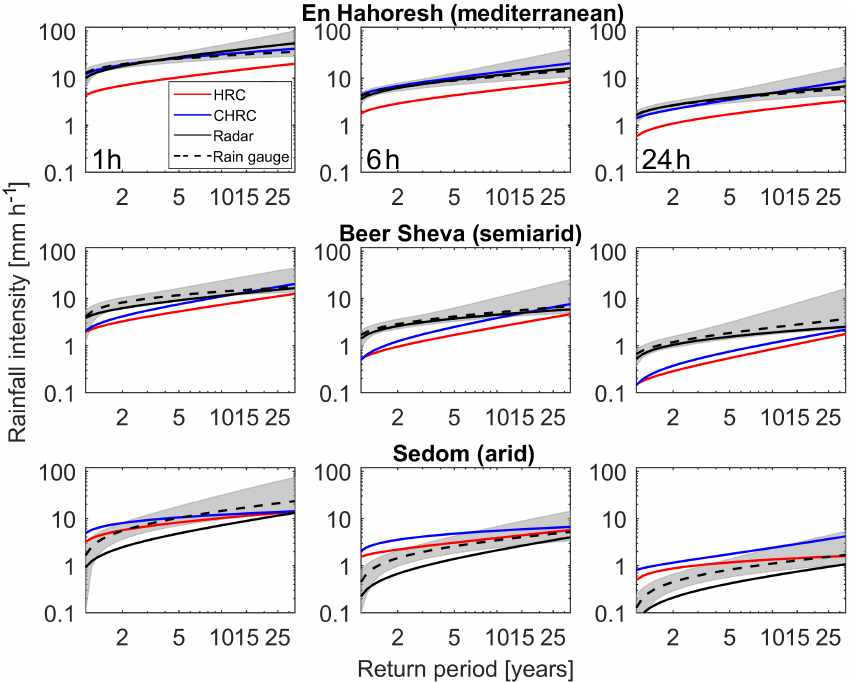
Figure 4. Visual comparison of the annual maxima and of the IDF curves derived for the examined 16 years (1998–2013) from HRC (red), CHRC (blue), radar (solid black), and rain gauge (dashed black). The shaded area represents the 95% confidence interval of the rain gauge IDF. Three example locations in the Mediterranean (En Hahoresh), semiarid (Beer Sheva) and arid (Sedom) climates and for 1, 6, and 24h durations are shown (see gauge location in Fig. 1).